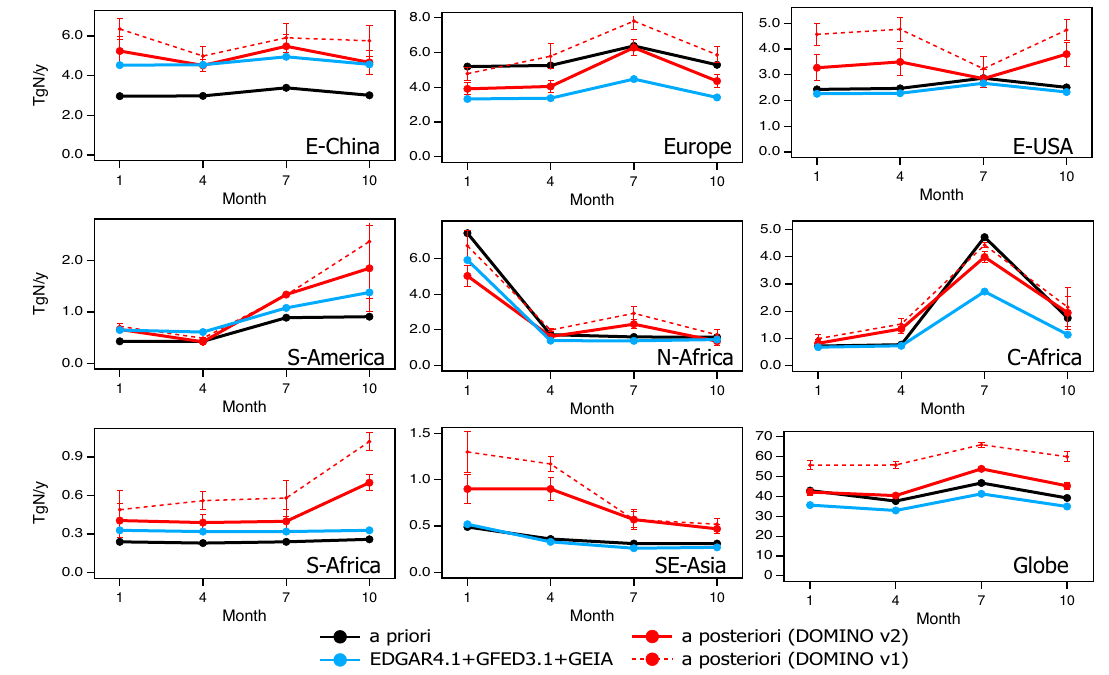
a posteriori (DOMINO v2) a posteriori (DOMINO v1) EDGAR4.1+GFED3.1+GEIA Fig. 7. Seasonal variations of the regional and global surface NO x emissions (in TgNyr − 1 ) obtained from the a priori emissions (black lines), the a posteriori emissions with DOMINO v2 data (red solid line) and DOMINO v1 data (red dotted line), and the newer inventories (EDGAR4.1+GFED3.1+GEIA, light blue lines), averaged over the 16th-30th of each month in January, April, July, and October 2005. The error bars represent the standard deviations of the a posteriori emissions during the analysis period. The results are shown for eastern China (top left panel), Europe (top center panel), the eastern United States (top right panel), South America (middle left panel), northern Africa (middle center panel), central Africa (middle right panel), southern Africa (bottom left panel), and Southeast Asia (bottom center panel), and the globe (bottom right